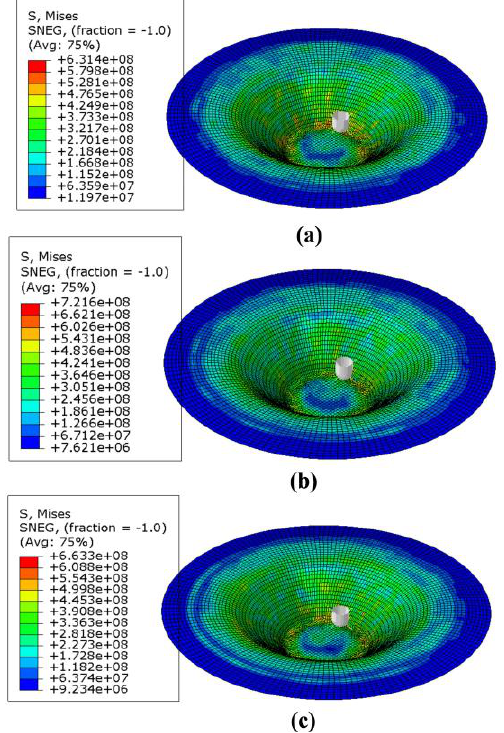
Figure 12. von Mises stress distribution for FFLD material model at ( a ) no fluid pressure, ( b ) pressure 0.2 bar, and ( c ) pressure 0.4 bar.